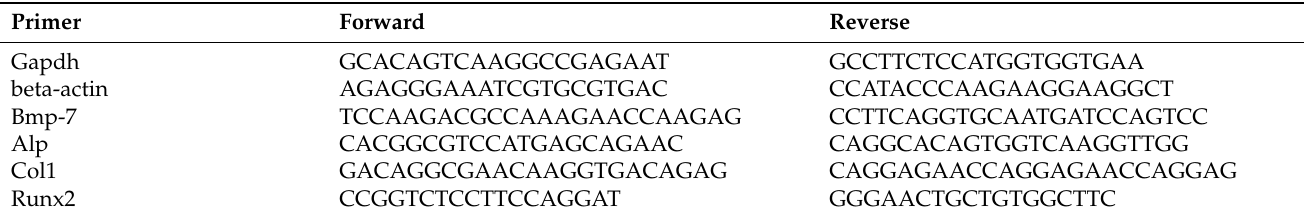
Table 1. The sequences of primers used for RT-PCR